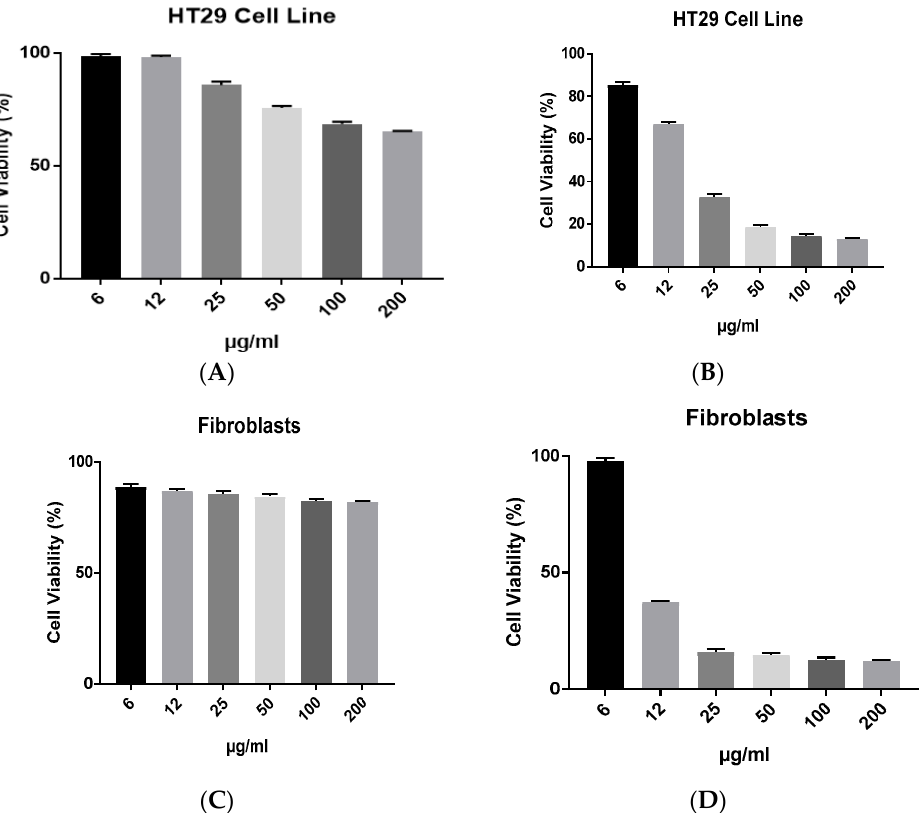
Figure 5. The effect of ( A ) biochar and ( B ) AgNPs on the viability of HT29 cell line and ( C ) biochar, ( D ) AgNPs on the viability of fibroblasts in 72 h cultures as measured by an MTT assay. The results are expressed as means of three measurements ± SD ( n = 3–4 independent replicates).